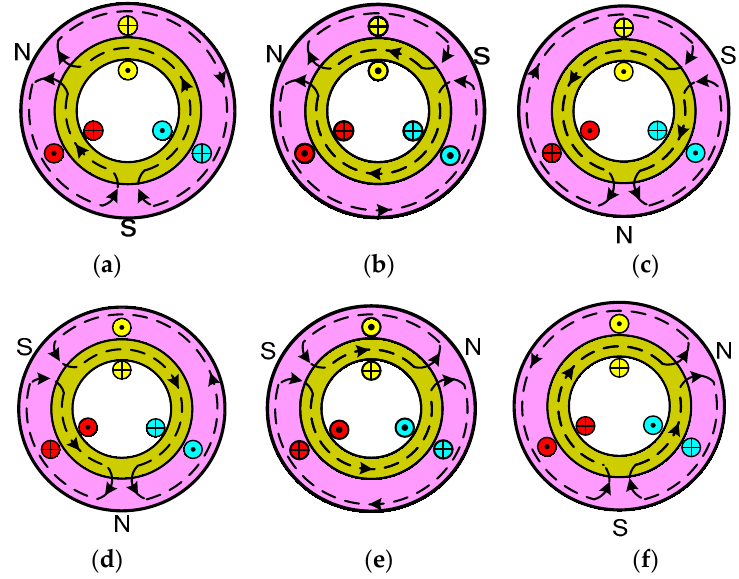
Figure 4. Armature magnetic fields versus time: ( a ) Time 1; ( b ) Time 2; ( c ) Time 3; ( d ) Time 4; ( e ) Time 5; ( f ) Time 6.